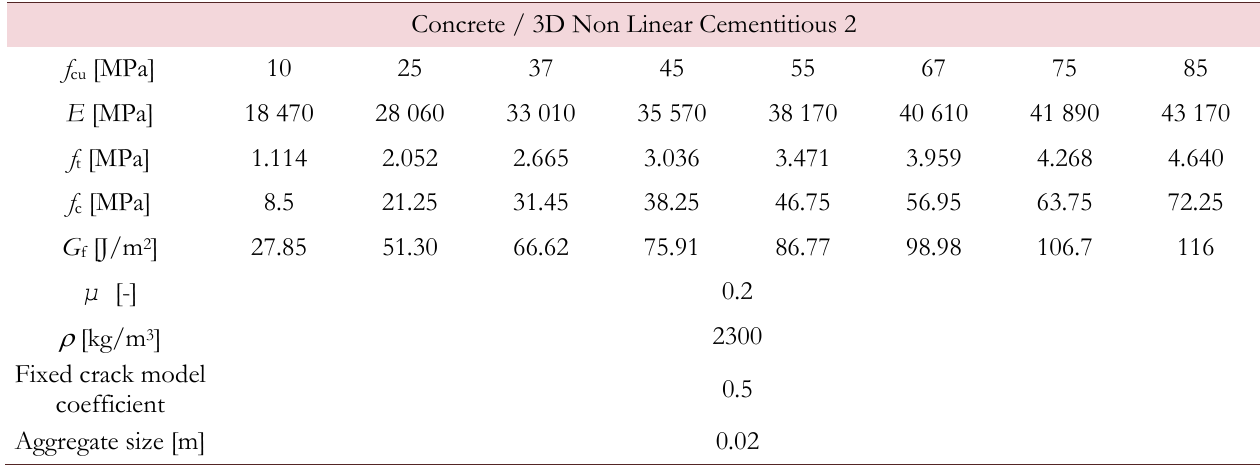
Table 3: Input parameters of the 3D Non Linear Cementitious 2 numerical model for concrete. R ESULTS AND DISCUSSION